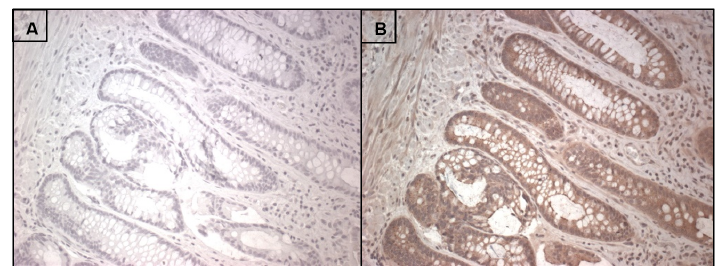
Figure 4. Renalase immunoreactivity in normal human colonic mucosa labeled with anti-m28-RNLS or 2.5% horse serum using an immunoperoxidase method labeled with ( A ) no primary antibody as a negative control; ( B ) anti-renalase m28 antibody. The specific brown RNLS labeling ( B ) is most prominent on the epithelial cells lining the crypts of the intestinal glands. Tissue samples were de-identified and acquired through a Yale HIC-approved protocol by Dr. Marie Robert.